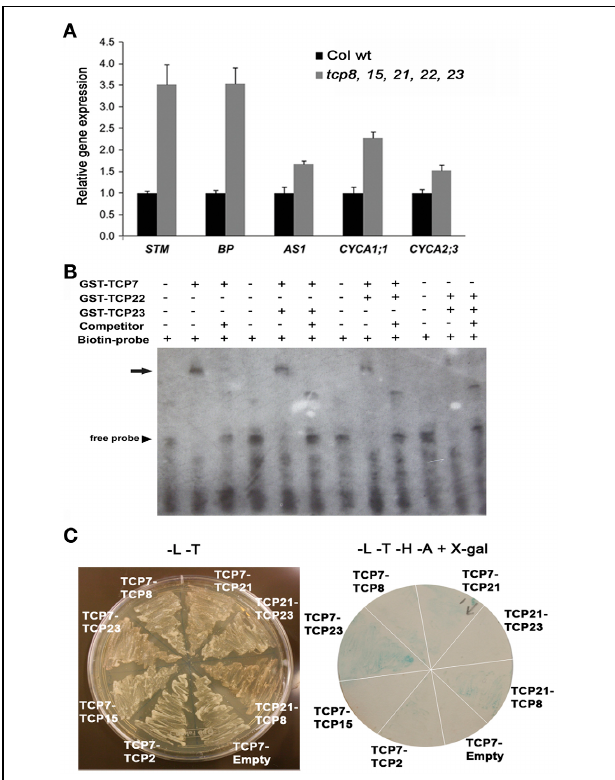
FIGURE 5 | Class I TCP factors regulate KNOX1 genes and are capable of protein–protein interaction. (A) Gene expression analysis by qPCR in Col wt and the pentuple mutant tcp8, 15, 21, 22, 23 . Error bars are SD of three biological replicates. (B) EMSA of the K-box region of the STM promoter. Tested were factors AtTCP7, AtTCP22 and AtTCP23 in combinations indicated. Arrow indicates shifted bands. (C) Yeast-two hybrid assay to test for TCP protein–protein interactions. Left panel, co-transformed yeast grown in media without aminoacids Leucine and Tryptophan (-L-T media); right panel, β –Gal filter assay: co-transformed yeast were replica-plated in media without Leucine, Tryptophan, Histidine and Adenine and plus X-gal (-L-T-H-A+X-gal). The factors assayed were class I TCP factors AtTCP7, AtTCP8, AtTCP15, AtTCP21 and AtTCP23 and the class II factors AtTCP2 and AtTCP3. Interactions with empty vectors were used as negative controls.